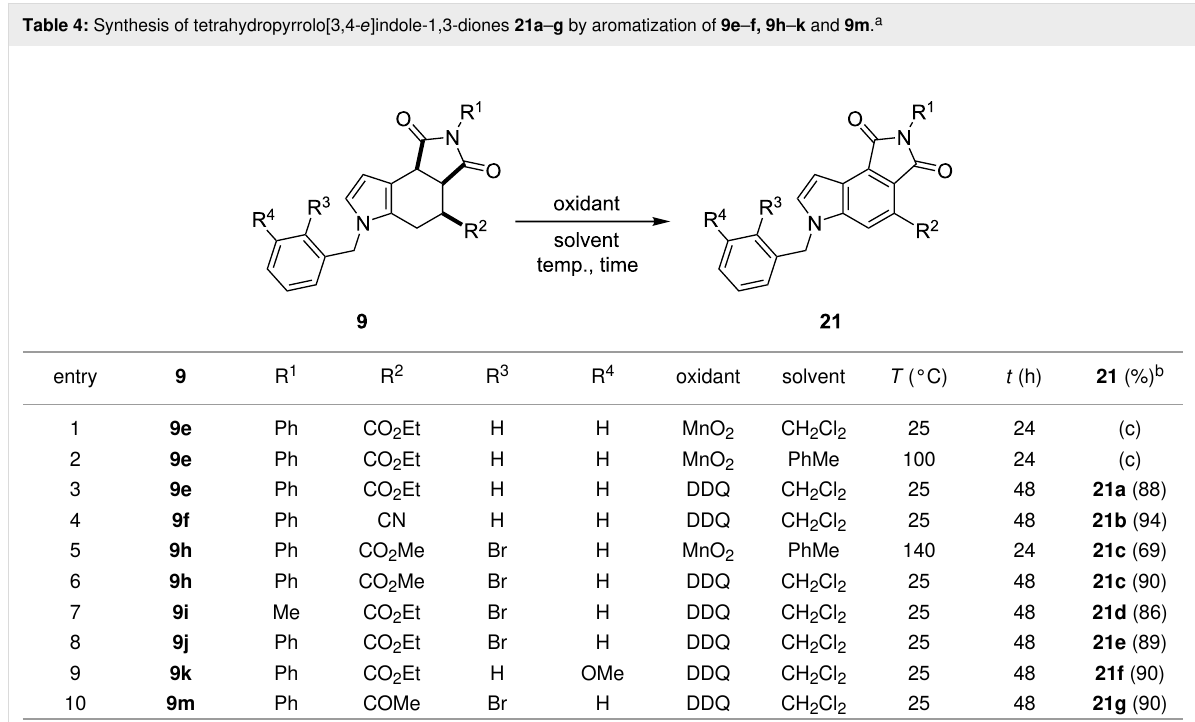
Table 4: Synthesis of tetrahydropyrrolo[3,4- e ]indole-1,3-diones 21a – g by aromatization of 9e – f, 9h – k and 9m .